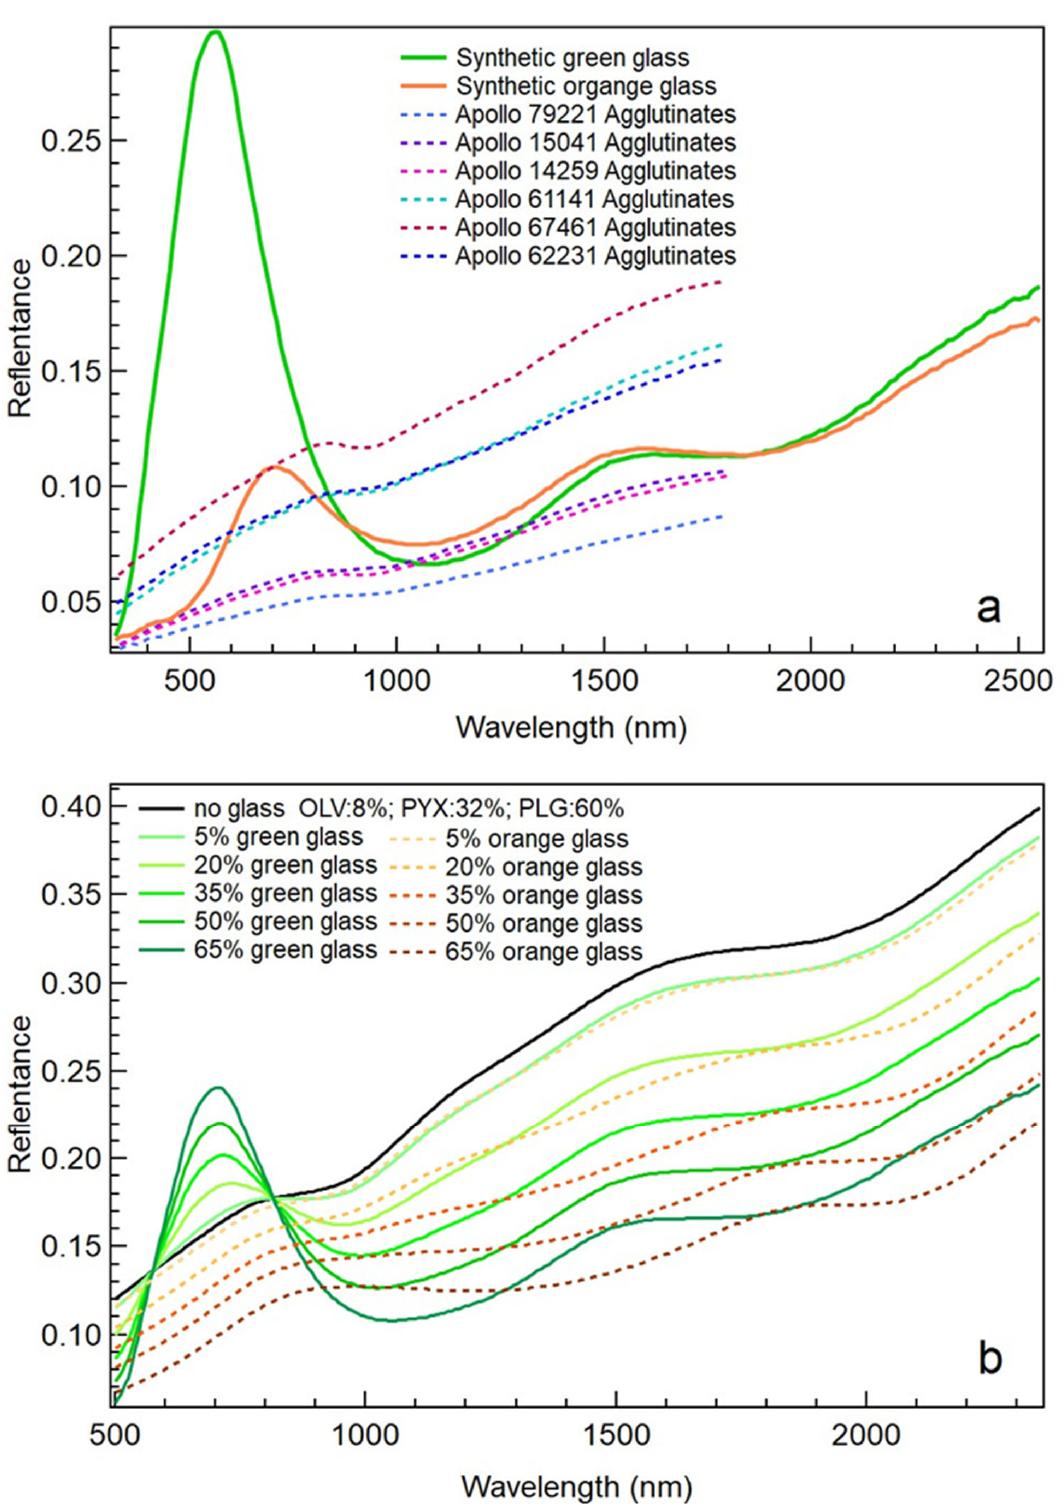
Figure 2. ( a ) The synthetic lunar green and orange glass from [19] and the Apollo sample agglutinates spectra from [25]; ( b ) VNIR spectra from our spectral library. We added a series content of glass to the mineral mixture (OLV:8 wt.%, PYX: 32 wt.%, PLG: 60 wt.%) to highlight the spectral differences between different content of synthetic lunar glasses in this study.